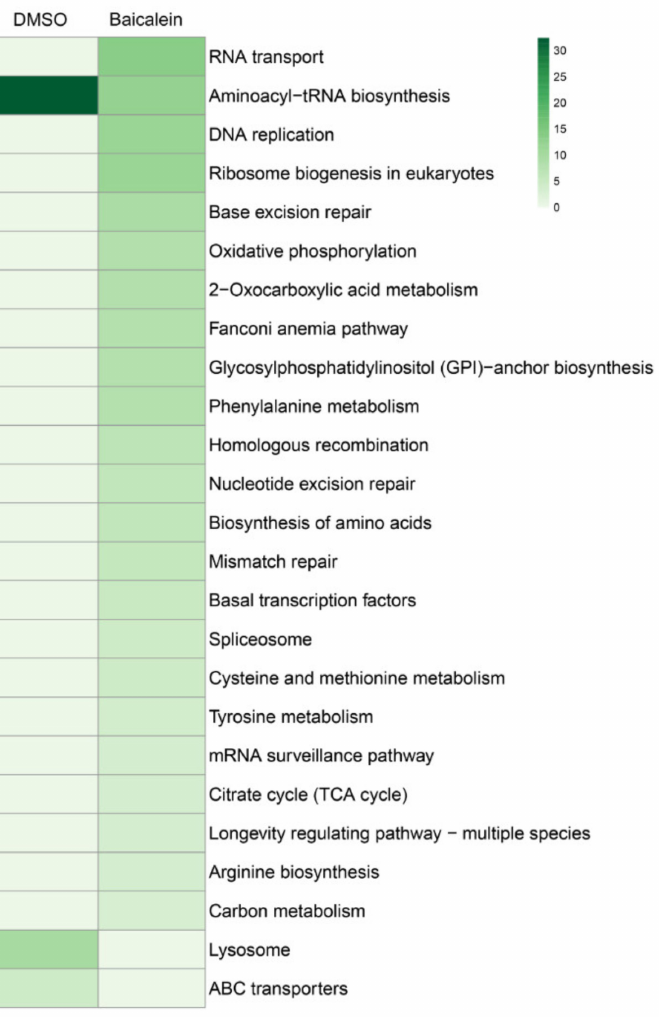
Figure 7. Principal component analysis (PCA) of C. elegans pathways altered by baicalein treatment (100 µ M) vs. control worms treated with